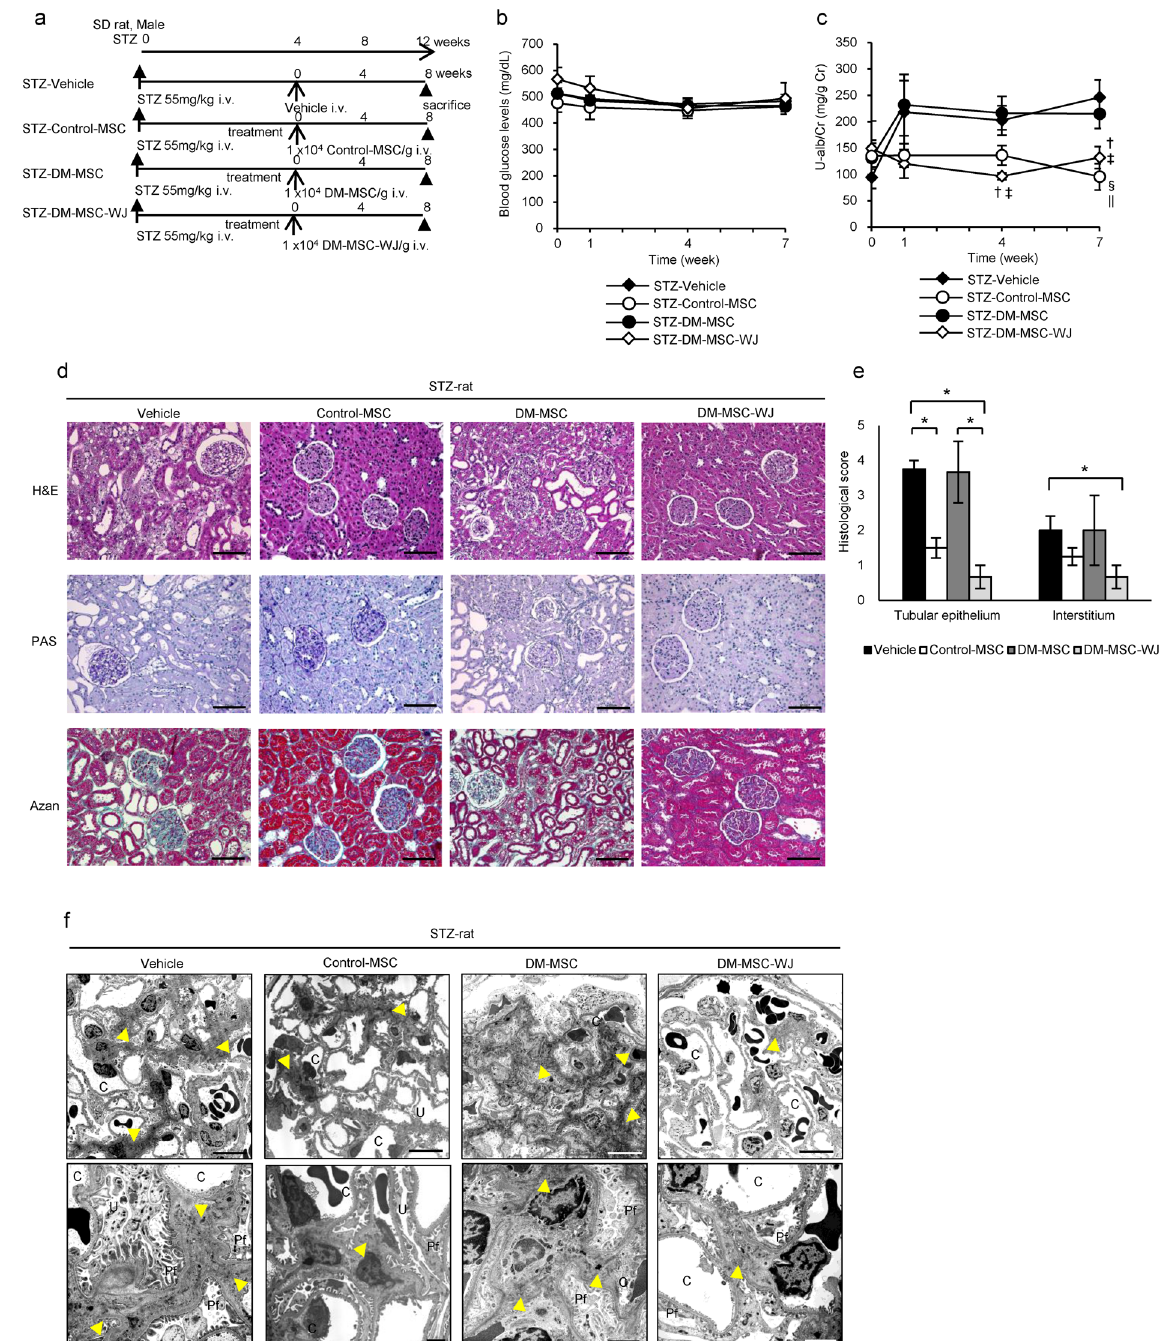
Figure 8. Therapeutic effect of DM-MSC which are activated by WJs for nephropathy in STZ-induced diabetic rats. ( a ) Experimental protocol for MSC therapies in STZ-diabetic rats. ( b ) Changes in blood glucose levels after initial BM-MSC administration. Values are expressed as mean ± SE of 4–6 animals. ( c ) Changes of U-alb/Cr after the administration of BM-MSC. Values are expressed as mean ± SE of 4–6 animals. † P < 0.05 STZ-DM- MSC-WJ vs. STZ-Vehicle; ‡ P < 0.05 STZ- DM-MSC-WJ vs. STZ-DM-MSC; § P < 0.05 Control-MSC vs. STZ- Vehicle; || P < 0.05 Control-MSC vs. STZ-DM-MSC. ( d ) Histological findings of the renal cortex in H&E, PAS, and Azan staining kidney sections at 8 weeks after the administration of BM-MSC in STZ-diabetic rats. Bar: 100 µ m. ( e ) Quantification of tubular epithelial damage and interstitial change in STZ-Vehicle, Control-MSC, STZ-DM-MSC and STZ-DM-MSC-WJ rats. Data shown are representative of five panels per animal at × 100 magnification. Data are expressed as mean ± SE of 3–4 animals. * P < 0.05. ( f ) Ultrastructural TEM analysis of the renal glomerulus in STZ-induced diabetic rats 8 weeks after initial administration of BM-MSC. C, glomerular capillary; Pf, podocyte foot process; Yellow arrowhead, mesangial matrixes. Bar: 10 µ m in upper panels, 2 µ m in lower